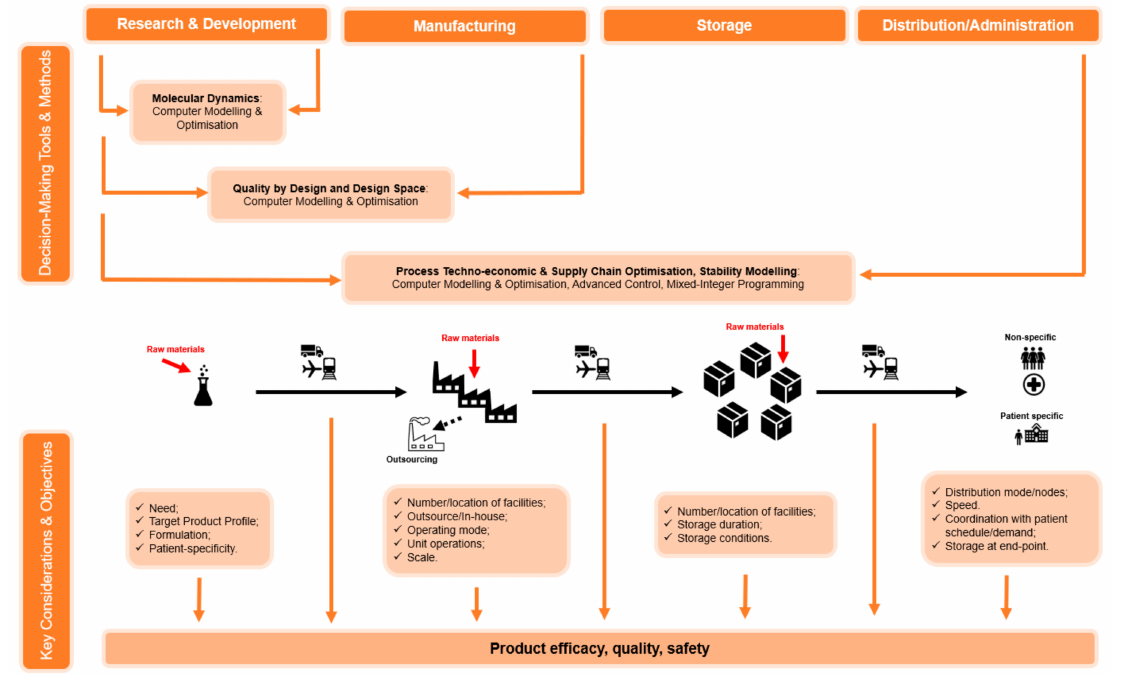
Figure 3. Pharmaceutical manufacturing and supply chain